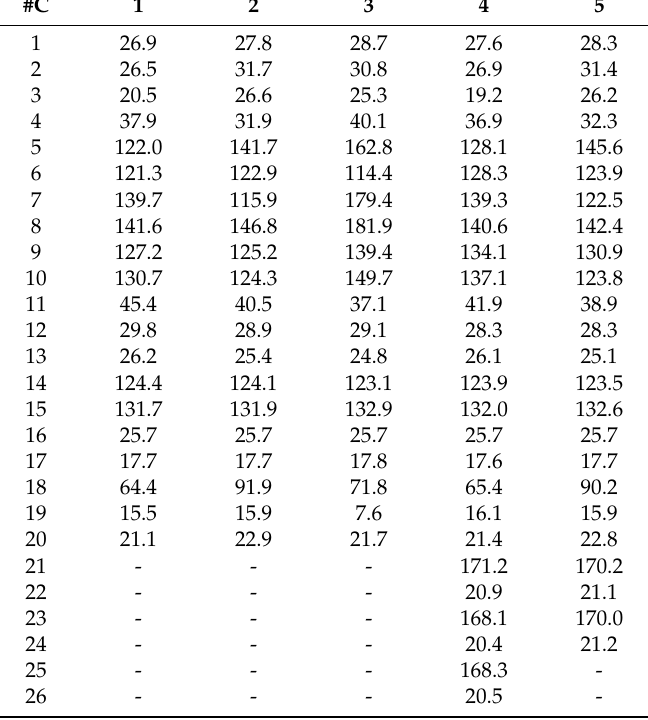
Table 2. 13 C-NMR data for Compounds 1 – 5 (100 MHz, δ in ppm, measured in CDCl 3 relative to